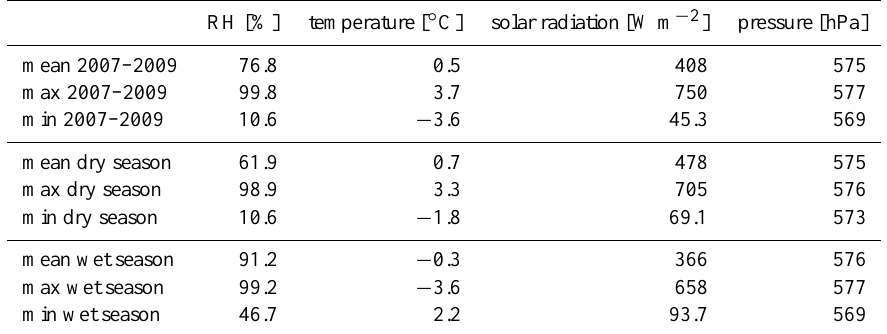
Table 2. Average meteorological parameters derived from daily means at Pico Espejo from March 2007–March 2009 and for individual seasons (for solar radiation only daytime data used).